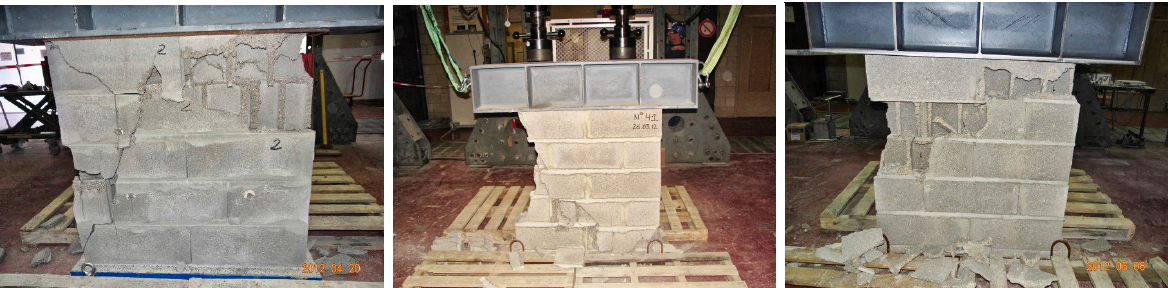
Fig. 6. Typical failure of dense aggregates masonry wallettes